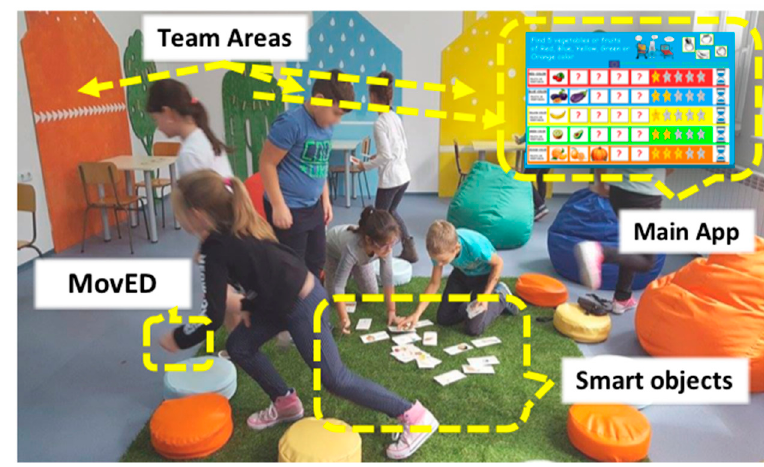
Figure 2. Bulgarian classroom setting.